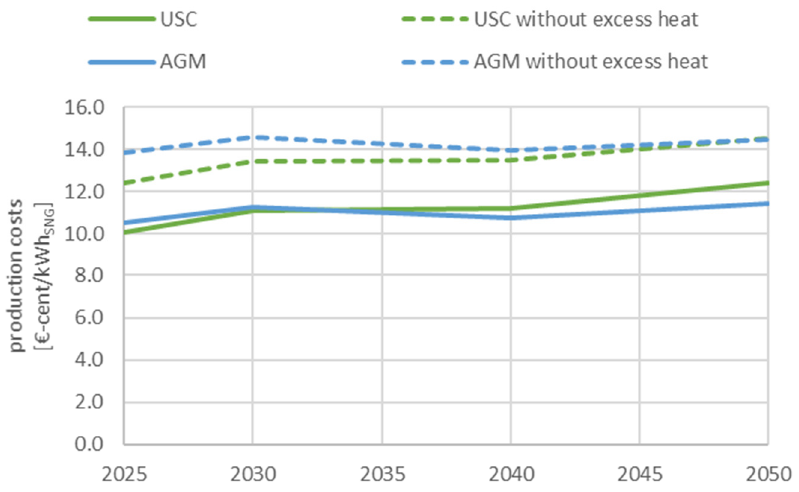
Figure 17. Geomethane production costs with and without revenue for excess heat for a 100,000 Nm³/h USC plant (advance configuration) and a comparable AGM.